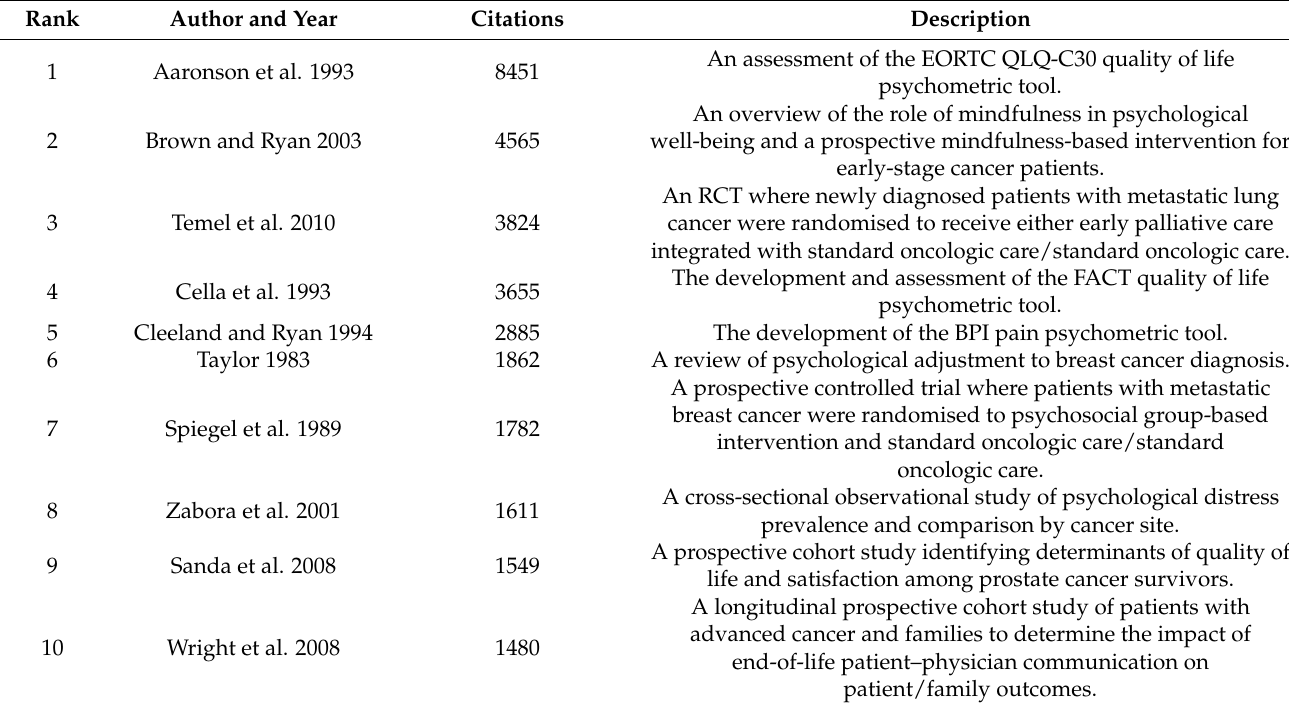
Table 3. The 10 highest-cited publications in psycho-oncology.